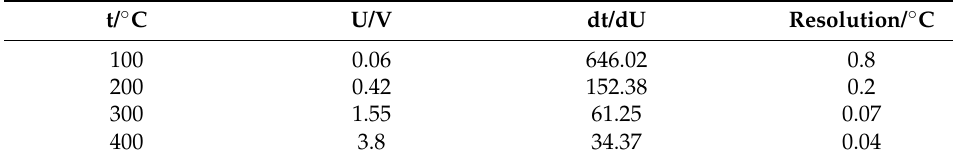
Table 3. Temperature resolution in different temperature ranges.